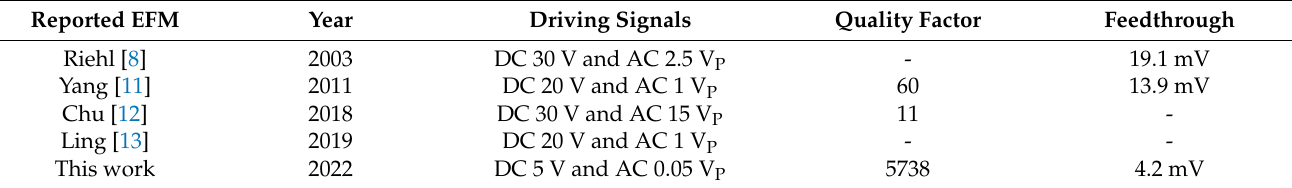
Table 2. Comparison with previously reported